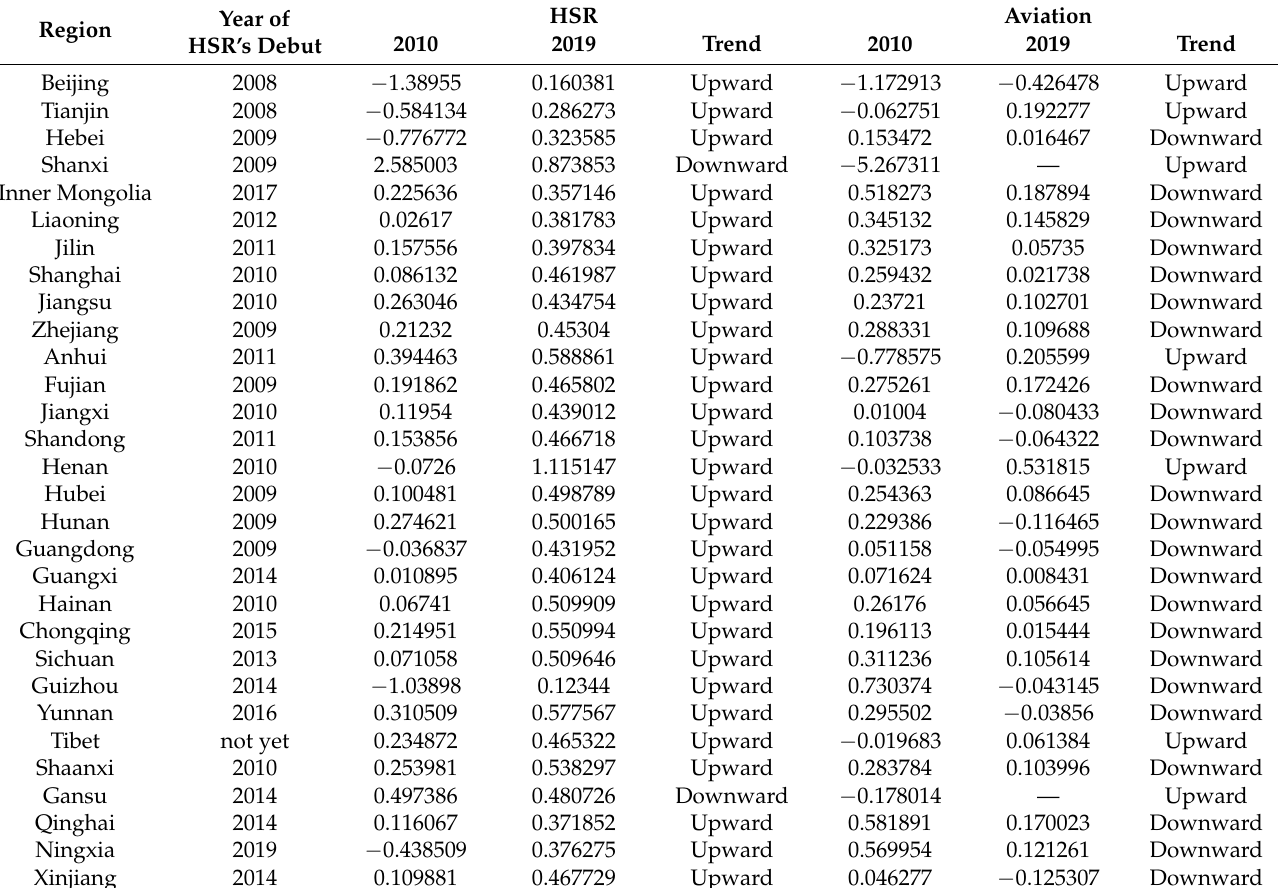
Table 3. GWPR Results of HSR and